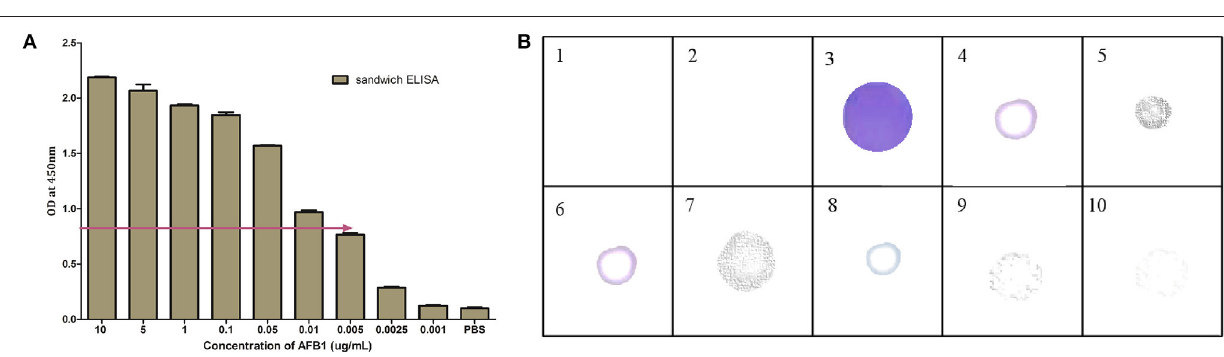
FIGURE 6 | Characterization of AFB1a Aptamer-anti-AFB1 antibody based sandwich immunoassay: (A) Limit of detection for developed sandwich ALISA platform determined by indirect ELISA against different AFB1 concentration (10–0.001 µ g/mL). (B) Cross reactivity analysis of developed sandwich immunoassay against 1 and 2-Blank, 3-AFB1, 4-AFB2, 5-AFG1, 6-AFG2, 7-Ochratoxin A, 8- Citrinin, 9-DON,